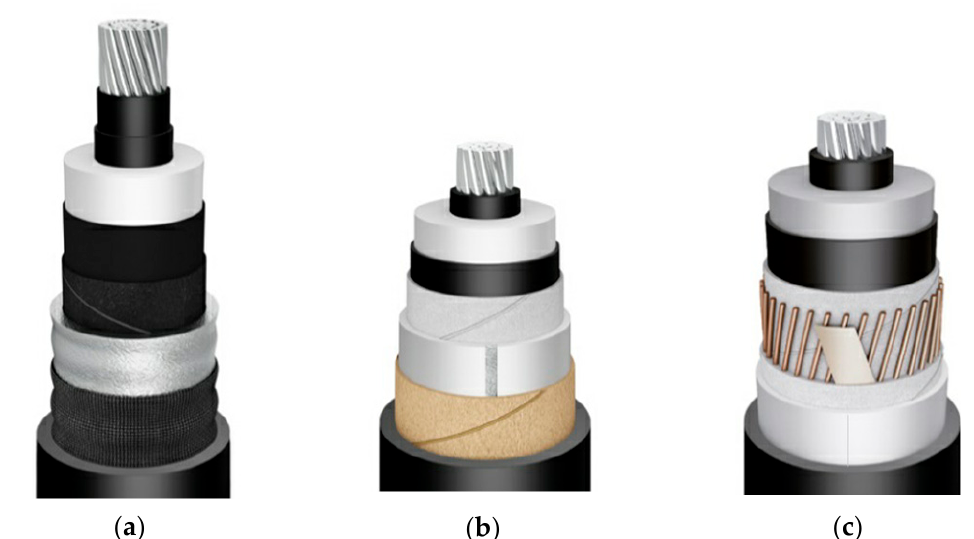
Figure 4. Cables construction with different aluminium water radial barriers: ( a ) extruded aluminium corrugated sheath; ( b ) smooth welded aluminium tape; and ( c ) laminated aluminium tape.